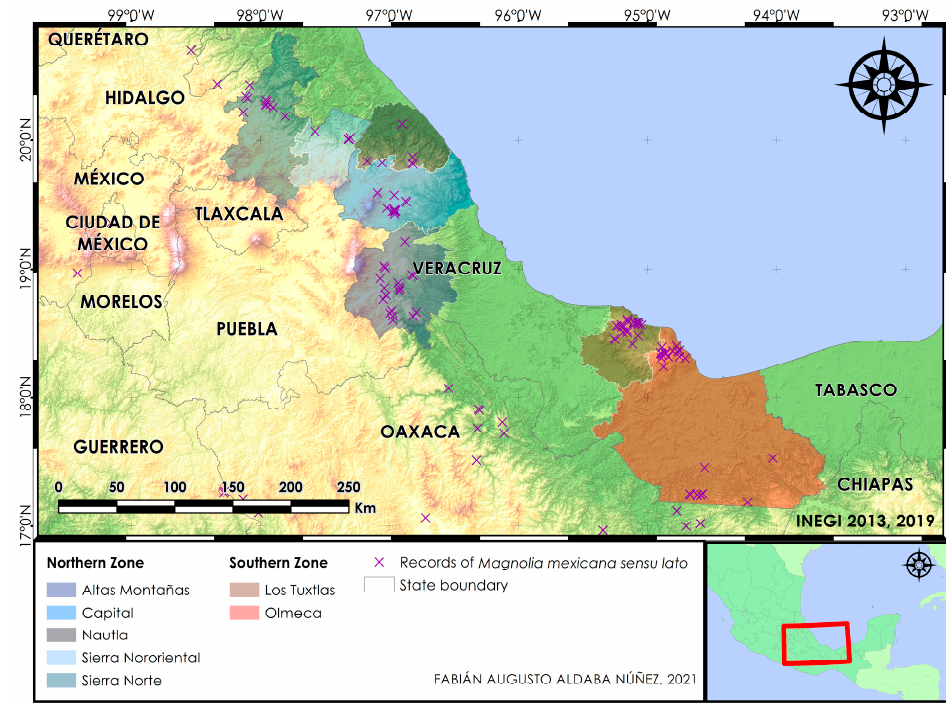
Figure 2. Map of study zones showing their natural regions; in Puebla and Veracruz states.